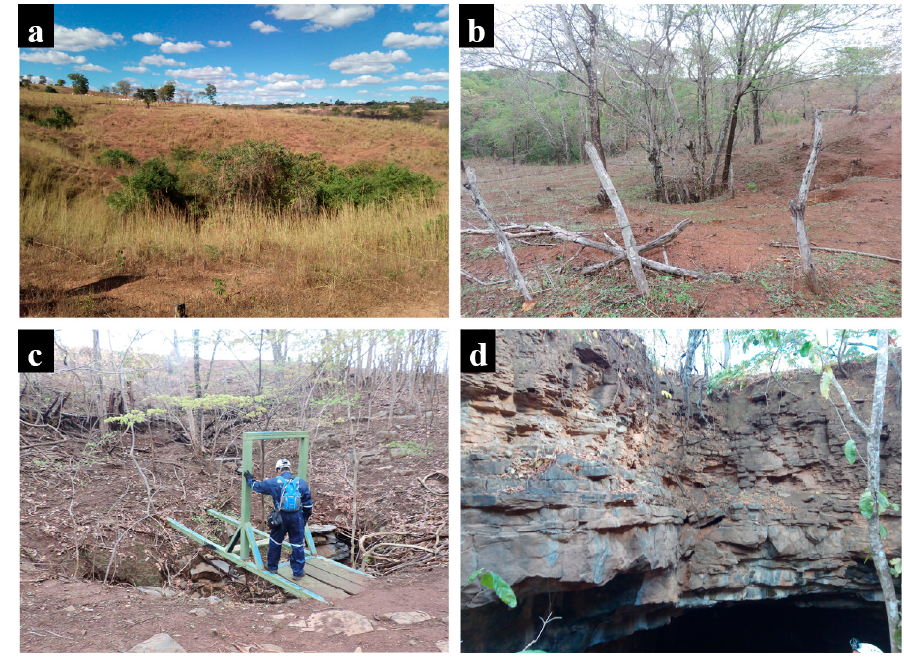
Figure 5. The photographs of the dolines ( a – c ) and a cave ( d ).